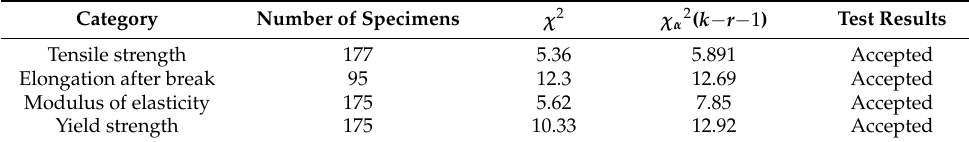
Table 5. Duplex stainless steel bar mechanical indicators normal distribution test